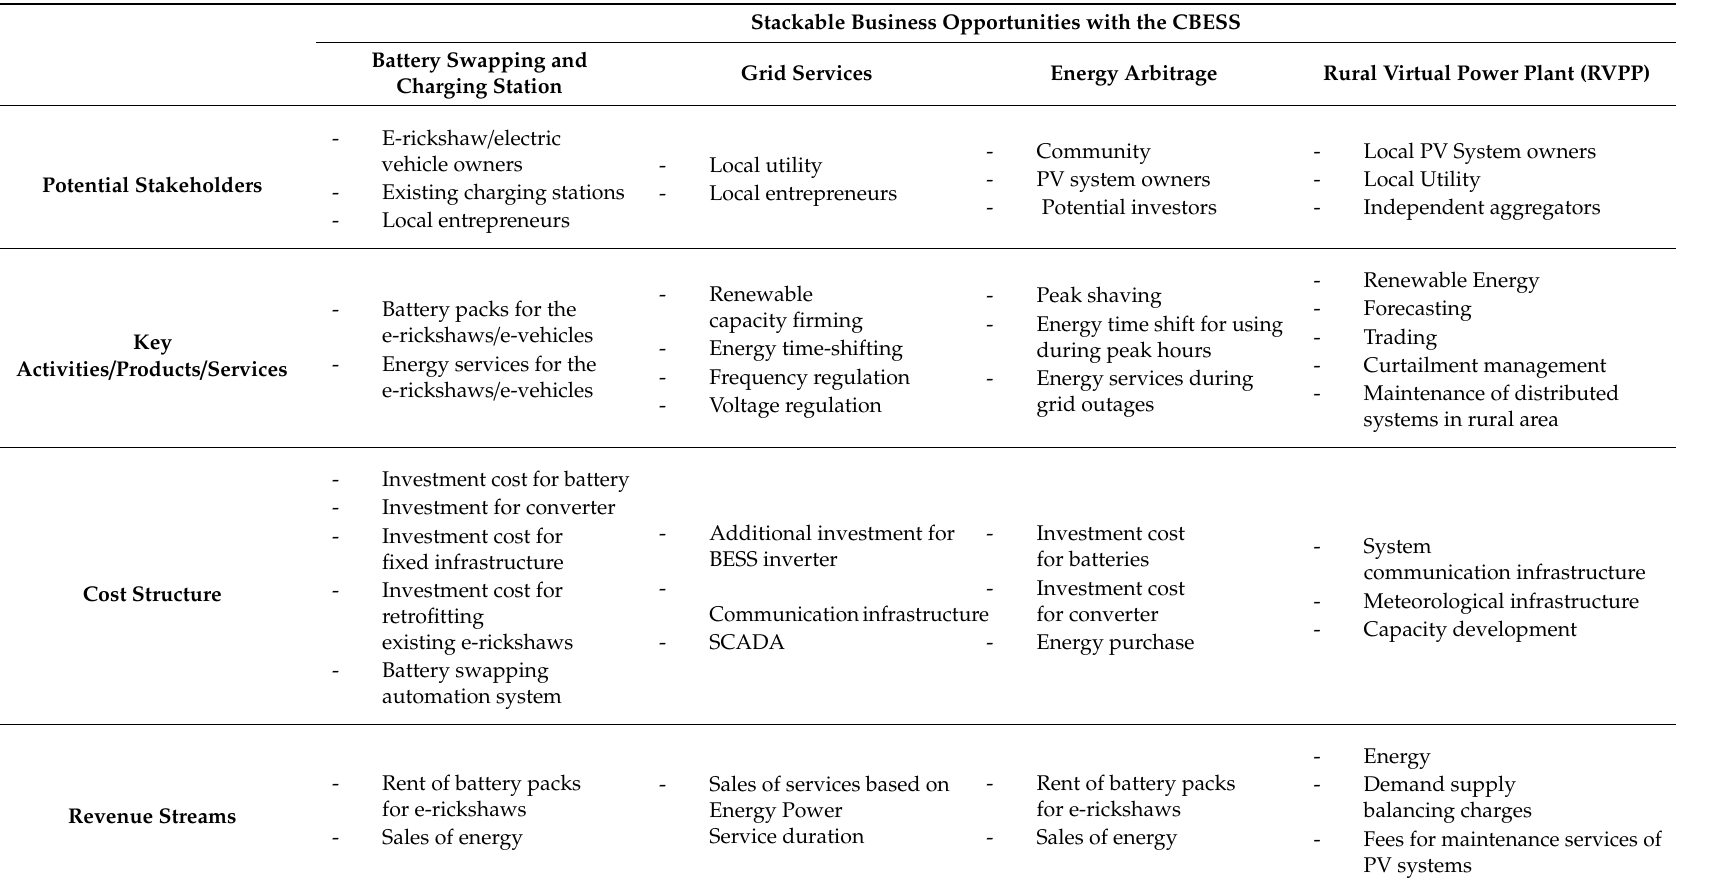
Table 5. Stackable business opportunity of the BSCS and CBESS based on business model